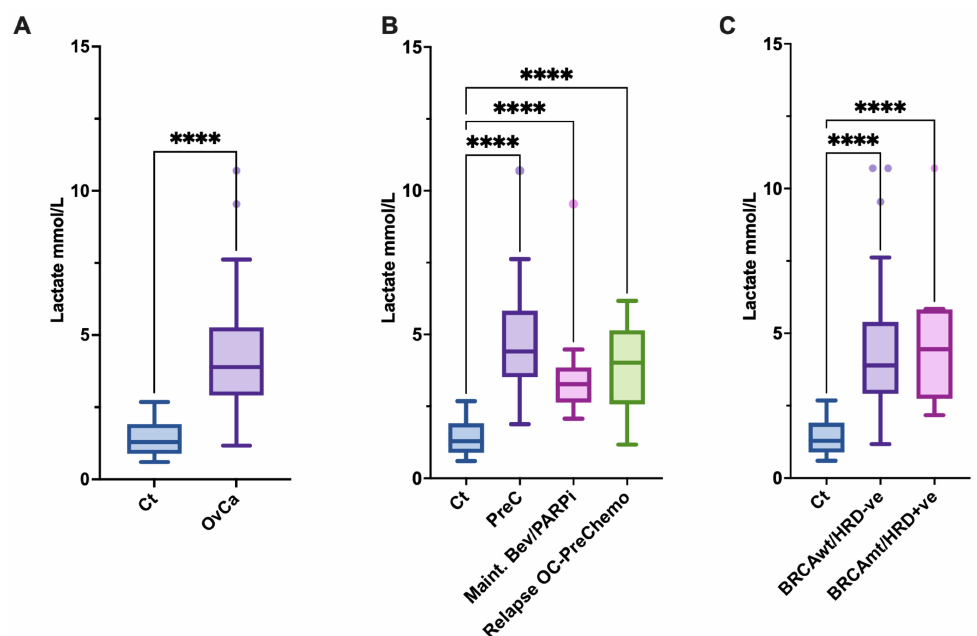
Figure 1. Lactate levels are elevated in OvCa. ( A ): Circulating lactate levels in controls (Ct; n = 45), patients with ovarian cancer (OvCa; n = 53); **** p < 0.0001. ( B ): Controls (Ct) compared to OvCa patients prior to any adjuvant chemotherapy treatment (Prechemotherapy, PreC), patients on mainte- nance bevacizumab, and or PARP inhibitors (Maint. Bev/PARPi), and those patients with samples taken prior to commencing chemotherapy treatment for HGSOC relapse (Relapse OC-PreChemo); **** p < 0.0001. ( C ): Controls (Ct) compared to OvCa patients with confirmed BRCA wild-type and HRD negative (BRCAwt/HRD-ve) versus patient carrying BRCA mutations or being identified as HRD positive (BRCAmt/HRD+ve); **** p <